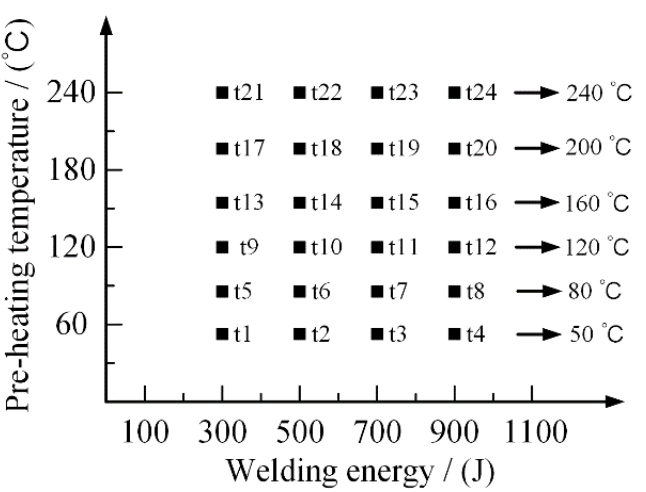
Figure 15. Design of the experiments.